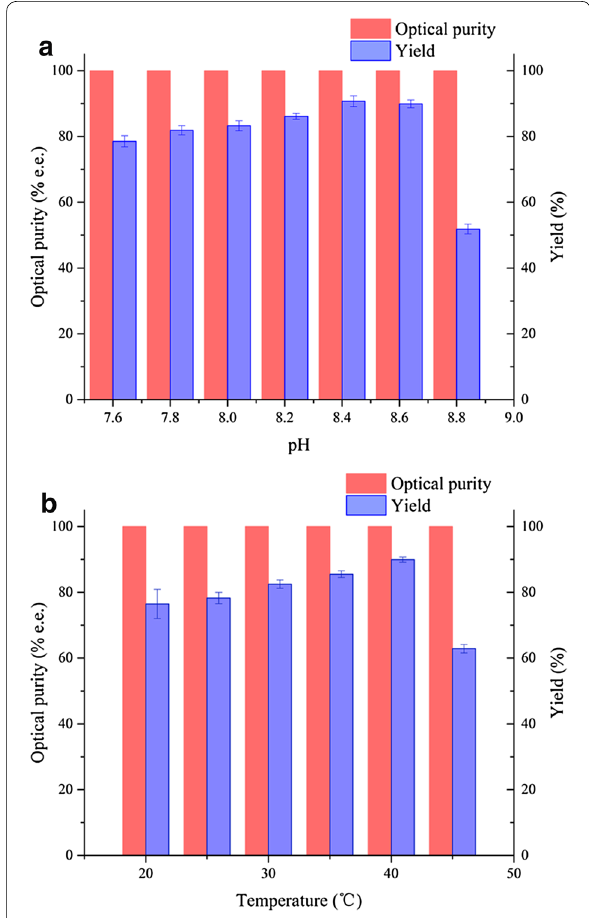
Fig. 4 Effect of pH ( a ) and temperature ( b ) on CR2-L-GDH catalyz- ing asymmetric synthesis of ( S )-DHTP. All reactions were carried out in 10 mL TEA buffer (0.1 mol L − 1 ) comprising 20 g L − 1 DKTP with addition of 40 g L − 1 glucose and 0.2 mmol L − 1 NADP + at 30 °C and 200 rpm for 12 h. All the results were the average of three parallel replicates